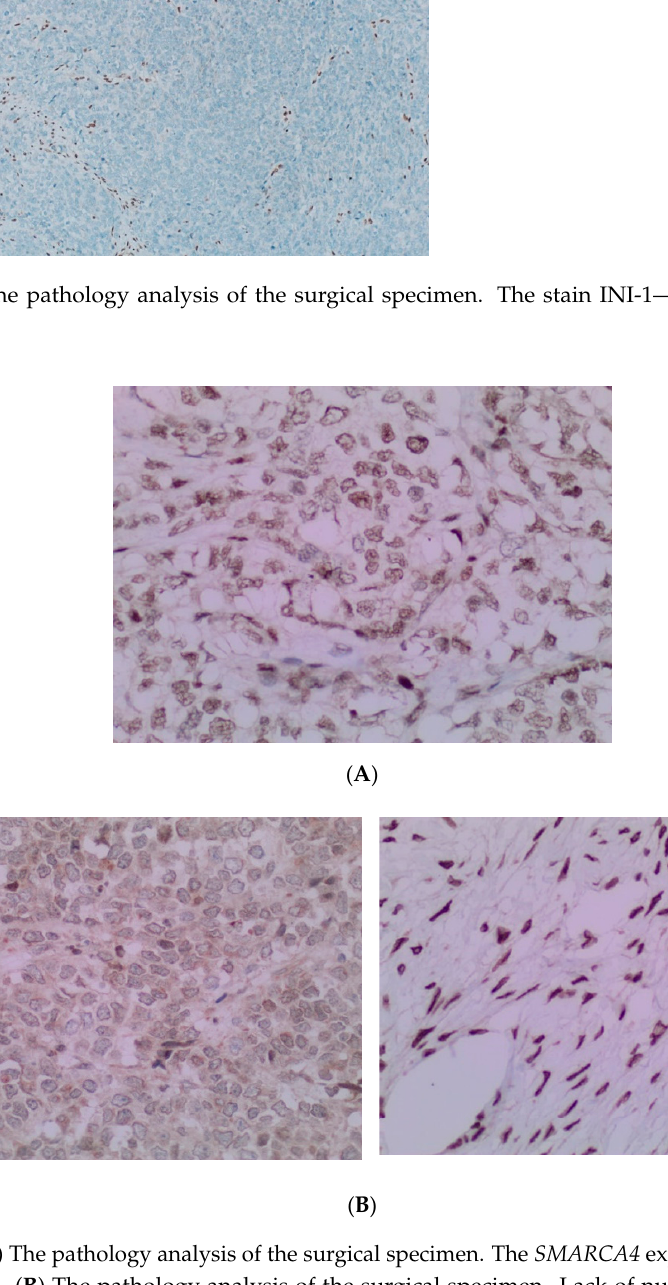
Figure 6. ( A ) The pathology analysis of the surgical specimen. The SMARCA4 expression is retained (IHC, 100×). ( B ) The pathology analysis of the surgical specimen. Lack of nuclear expression of SMARCA2 is noted ( left ) with the internal control of the SMARCA2 in the ovarian stroma ( right ). (IHC, 100×).